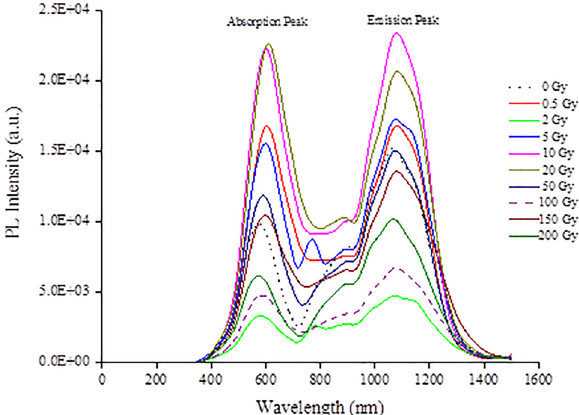
60 Co gamma irradiation doses ranging from 0 to 200